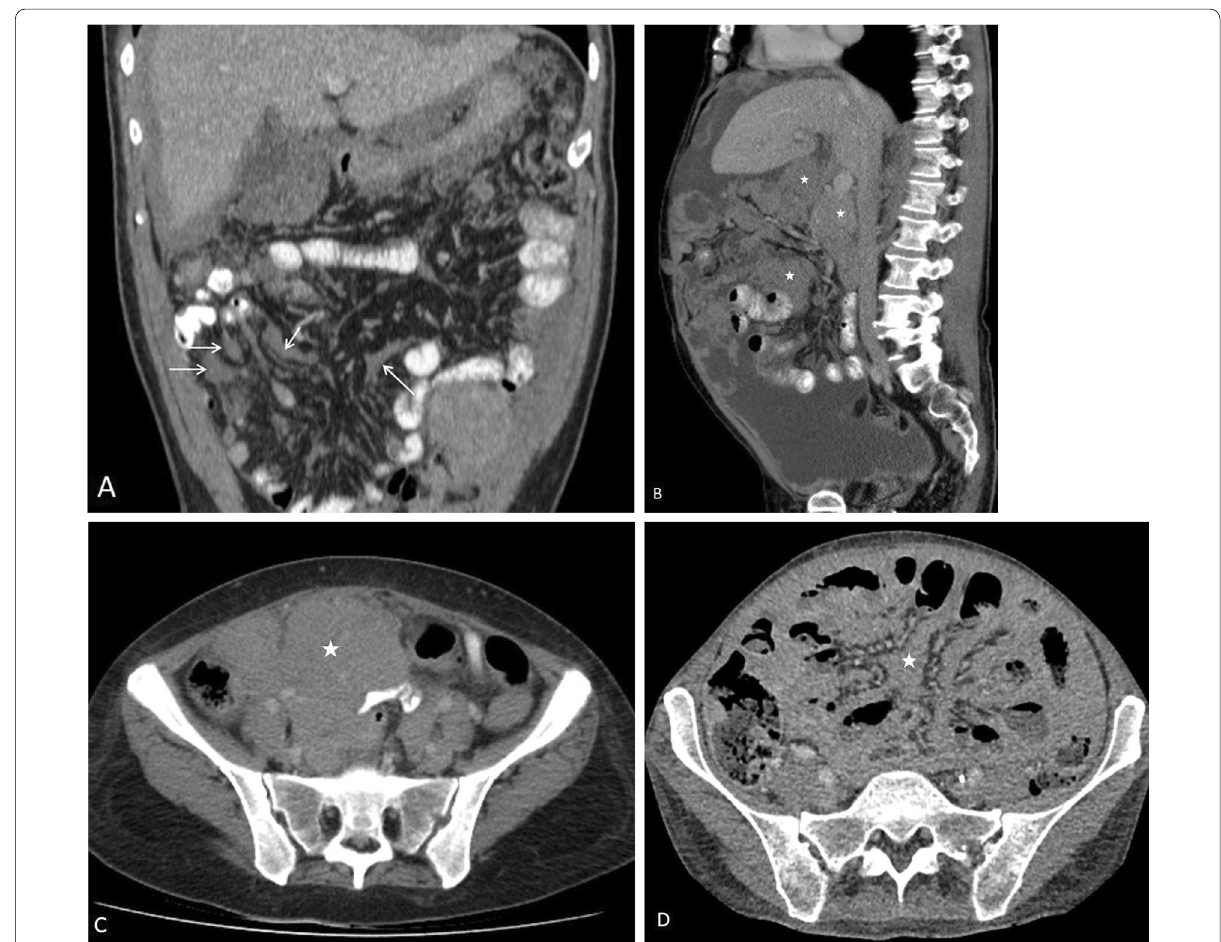
Fig. 16 a – d CT images of different patients with malignant peritoneal mesothelioma showing findings of advanced mesenteric disease. a Nodular mesenteric fold thickening (arrows). b Sagittal CT showing soft tissue masses in the root of mesentery (*). c Mesenteric soft tissue mass (*) encasing small bowel. d Stellate mesentery on CT, which represents gross nodular thickening and retraction of the mesentery